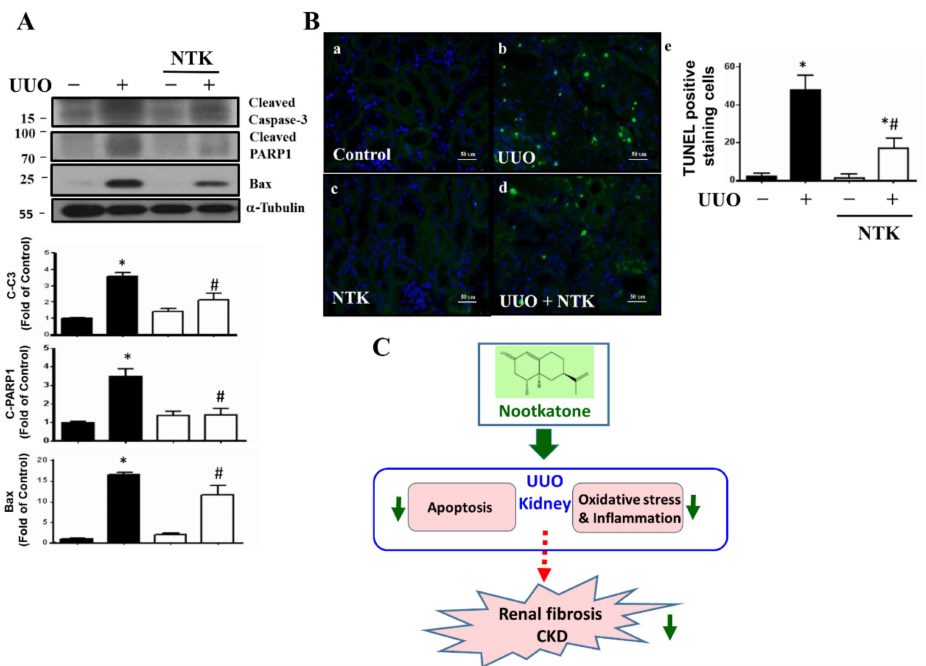
Figure 7. Effects of Nootkatone treatment on the renal cell apoptosis in the kidneys of UUO mice. Vehicle or Nootkatone (NKT) was orally given to the sham or UUO mice for 14 days. Protein expression levels of apoptotic molecules were determined by Western blotting ( A ). The TUNEL- positive cells are shown in ( B ). Data are presented as mean ± SD ( n = 6). a, Control; b, UUO; c, NTK; d, UUO+NTK. * p < 0.05 vs. the sham control group. # p < 0.05 vs. the UUO group. C-C3: